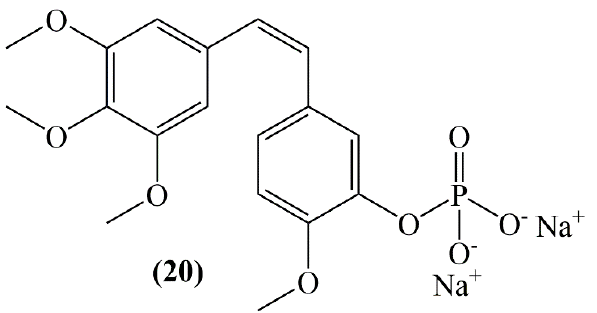
Figure 8. Structure of combretastatin A-4 disodium phosphate ( 20 ).